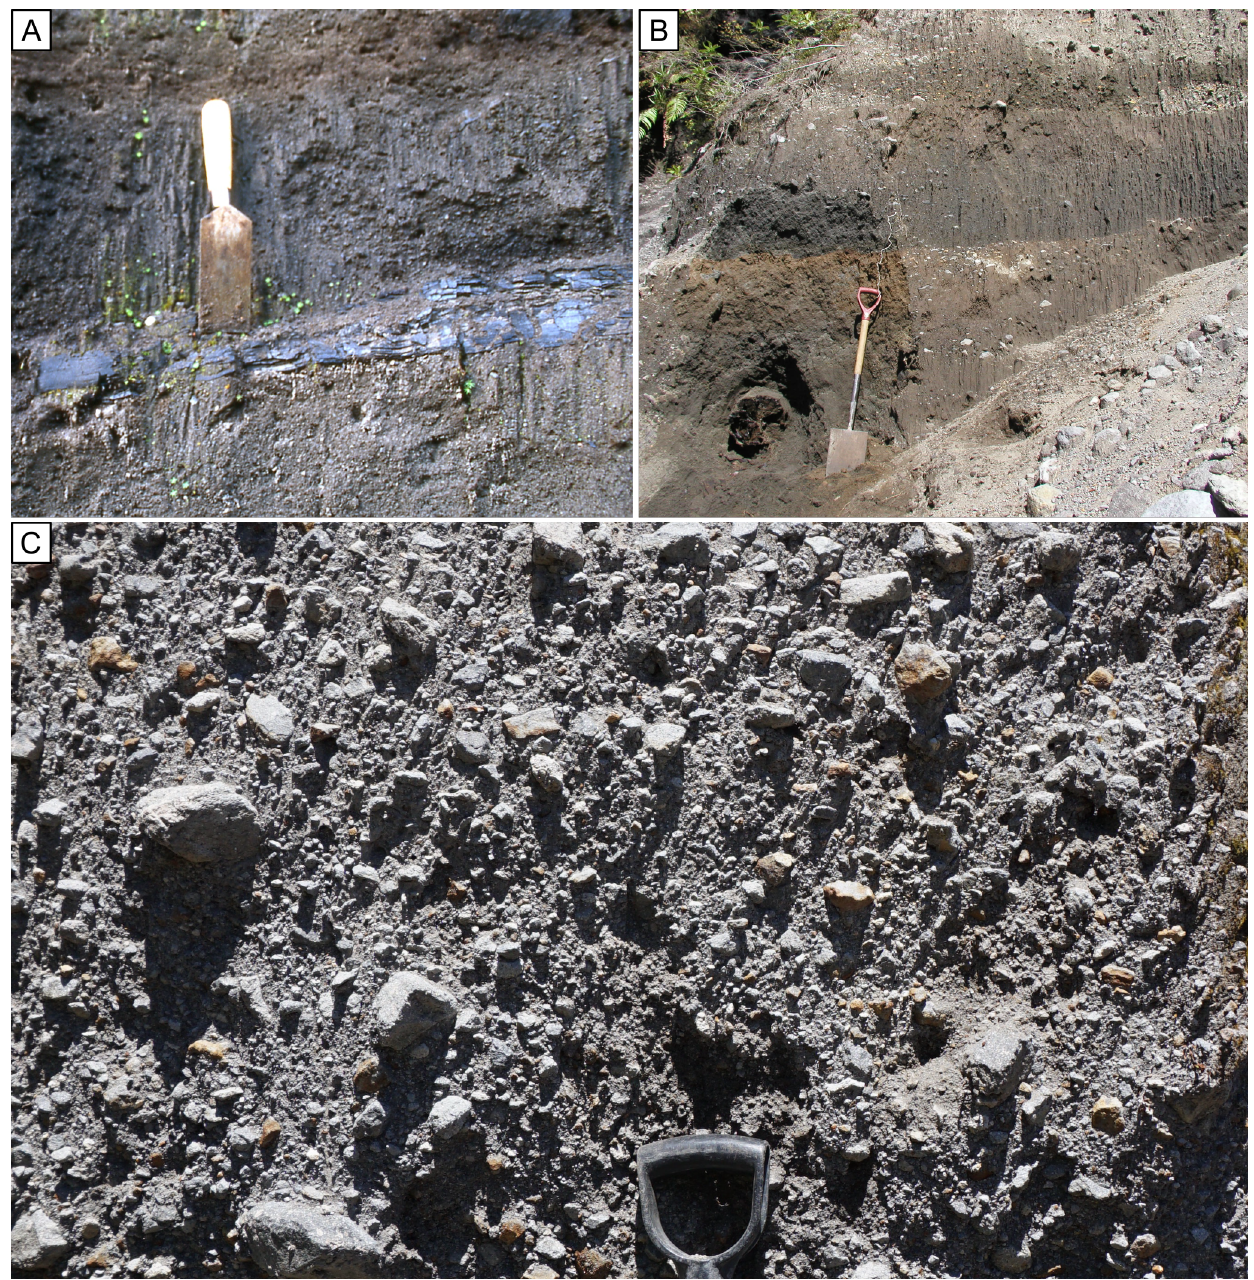
Figure 1: Photos of typical block-and-ash flow deposit characteristics: [A] charcoalised tree branch. [B] BAF sequence with the lowest brown unit containing a charred tree trunk and oxidised reddish upper contact. [C] BAF deposit typical view in outcrop—massive, poorly sorted, with angular and fractured, mostly grey andesite clasts. Examples are from the Waiweranui unit, Maero Formation, Mt.